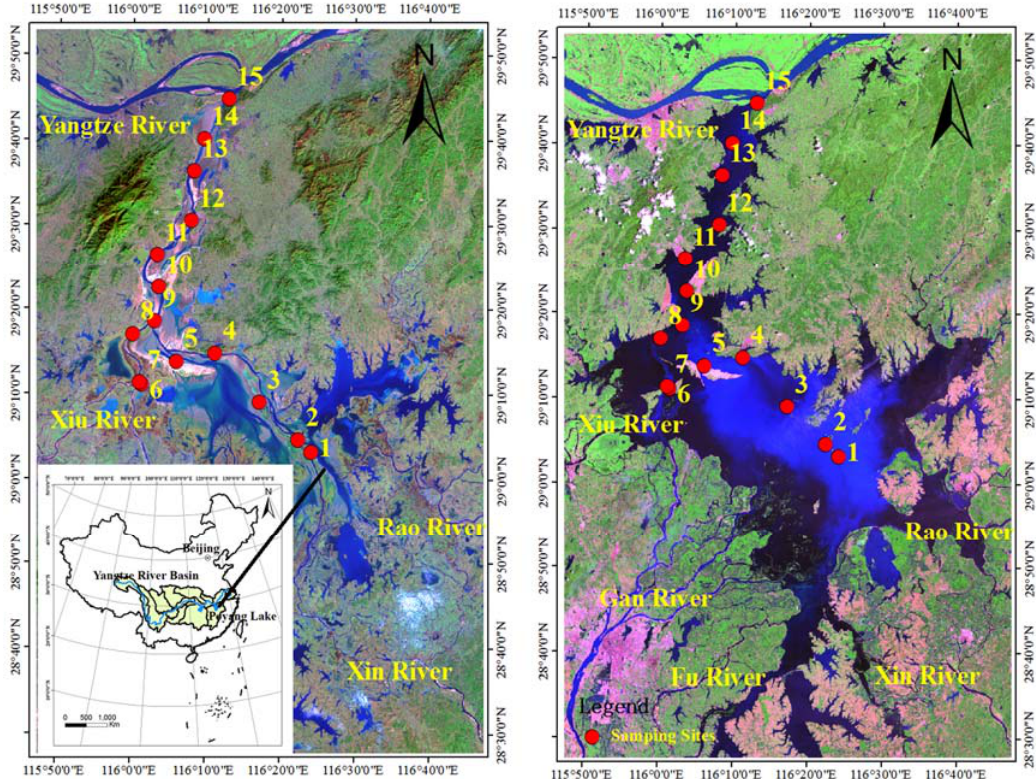
Figure 1. Seasonal variations of Poyang Lake, China (winter (January) on the left , summer (July) on the right ) and location of the sampling sites.